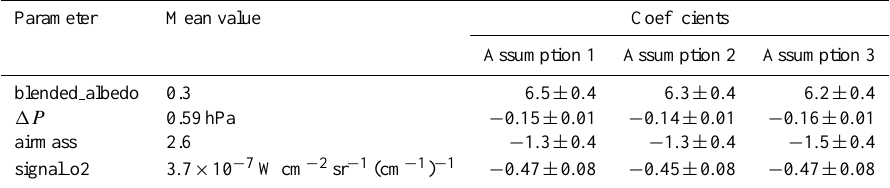
Table B2. Parameters and values for Eq. (4) for the v2.9 land data. The coefficients list the values for three assumptions of the X CO in the Southern Hemisphere: 1, that there is a small seasonal cycle and a 1.89ppmyr − 1 secular increase (i.e., Eq. 4); 2, that there is only a 1.89ppmyr − 1 secular increase (i.e., no seasonal cycle); and 3, that there is a small seasonal cycle, a 1.89ppmyr − 1 secular increase, and a − 1ppm gradient between 25 ◦ S and 55 ◦ S. The errors are twice the bootstrapped standard errors. The coefficients have units ofppm/unit of blended albedo,ppm/hPa,ppm/airmass and ppm/(10 7 Wcm − 2 sr − 1 (cm − 1 ) − 1 ),